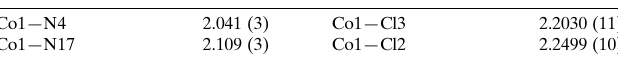
Selected bond lengths (A˚ ).